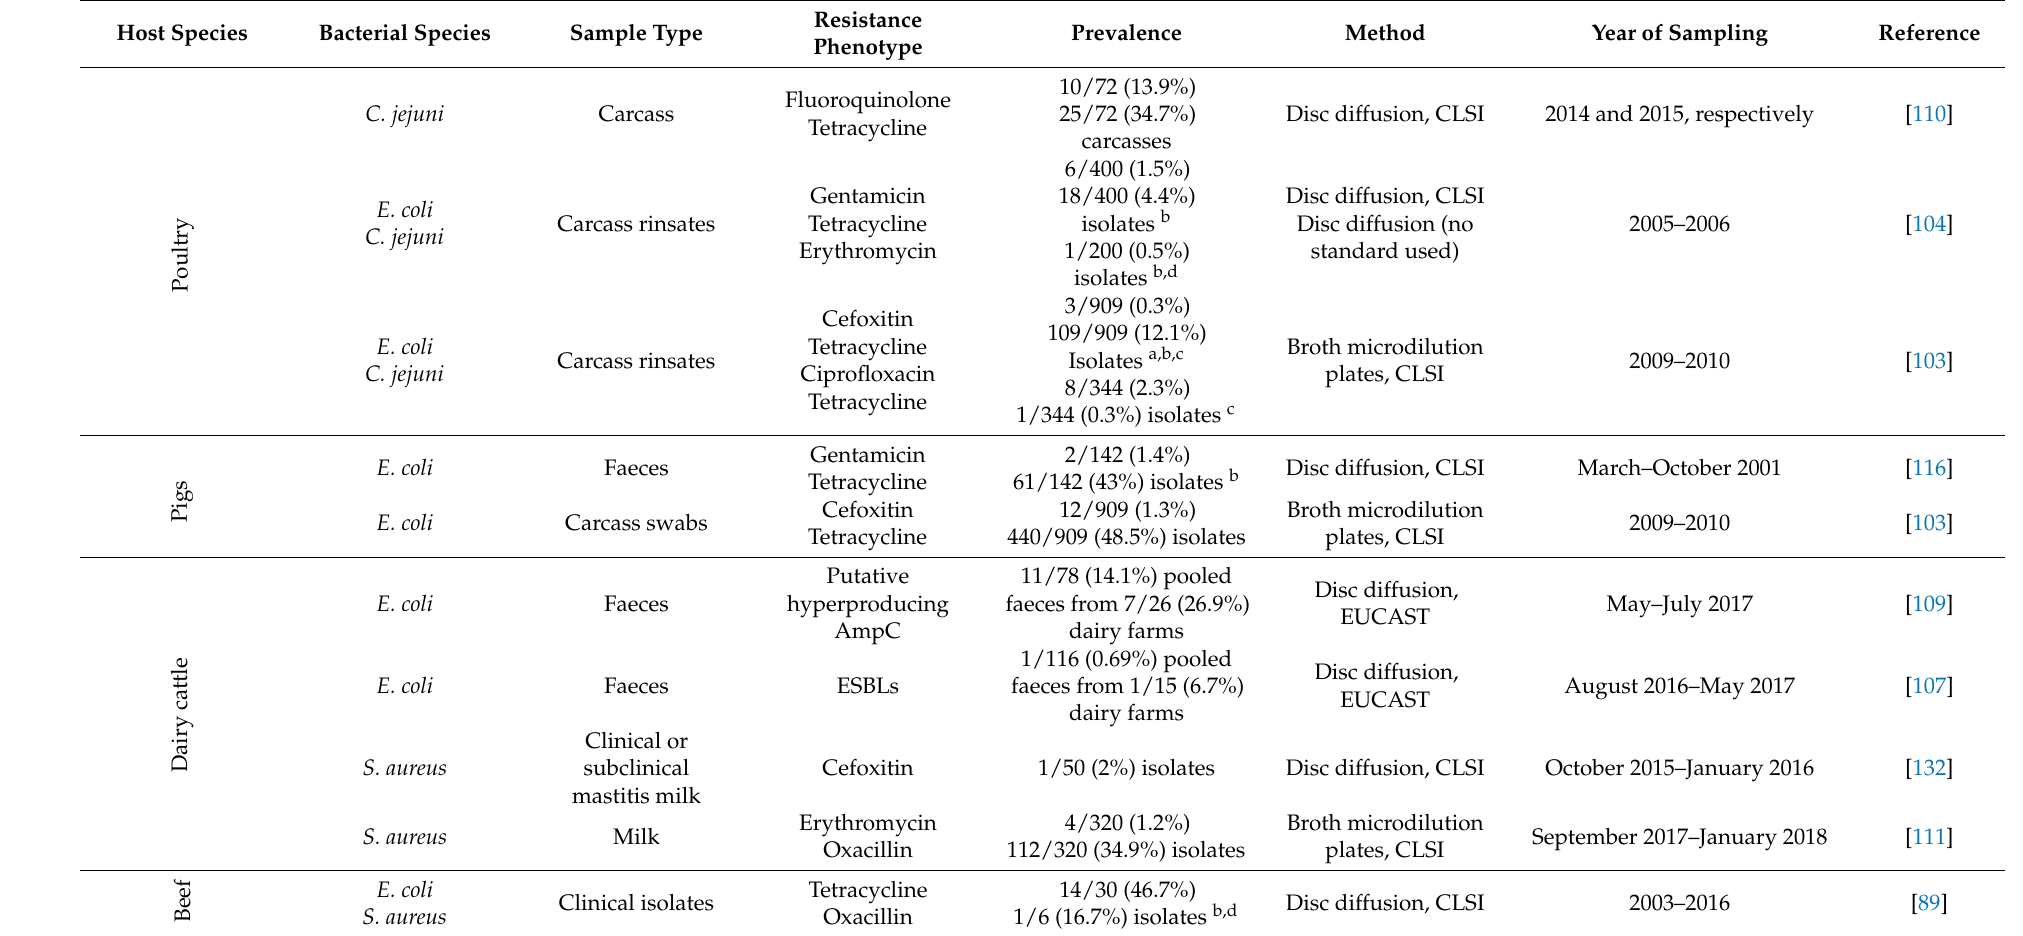
Table 1. Antimicrobial resistance in New Zealand farm and companion